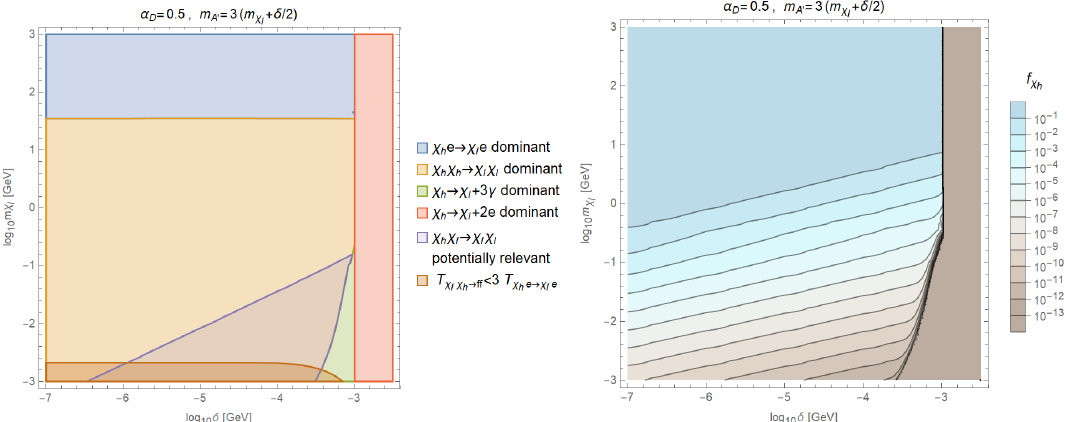
Figure 4 . The left-hand side shows the regions of the parameter space where the abundance of the excited sate at recombination is set by the decay to electrons, decay to photons, scattering off fermions, or scattering of dark matter. We also show the region where other processes may further deplete the abundance and the region where our approximations start to become less precise. The right-hand side shows the contours of the relative abundance of the dark matter excited state at T rec. , the recombination temperature. The abundance decreases sharply in regions where the decay processes dominate and at a slower rate when the scatterings are dominant. Analogous plots for additional dark-sector benchmarks are shown in figures 18 and